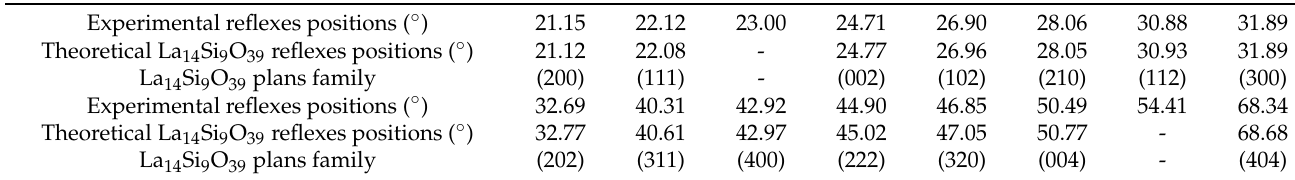
Figure 4. XRD patterns of LGS crystals. Table 1. Experimental and theoretical (La14Si9O39) diffraction angles.